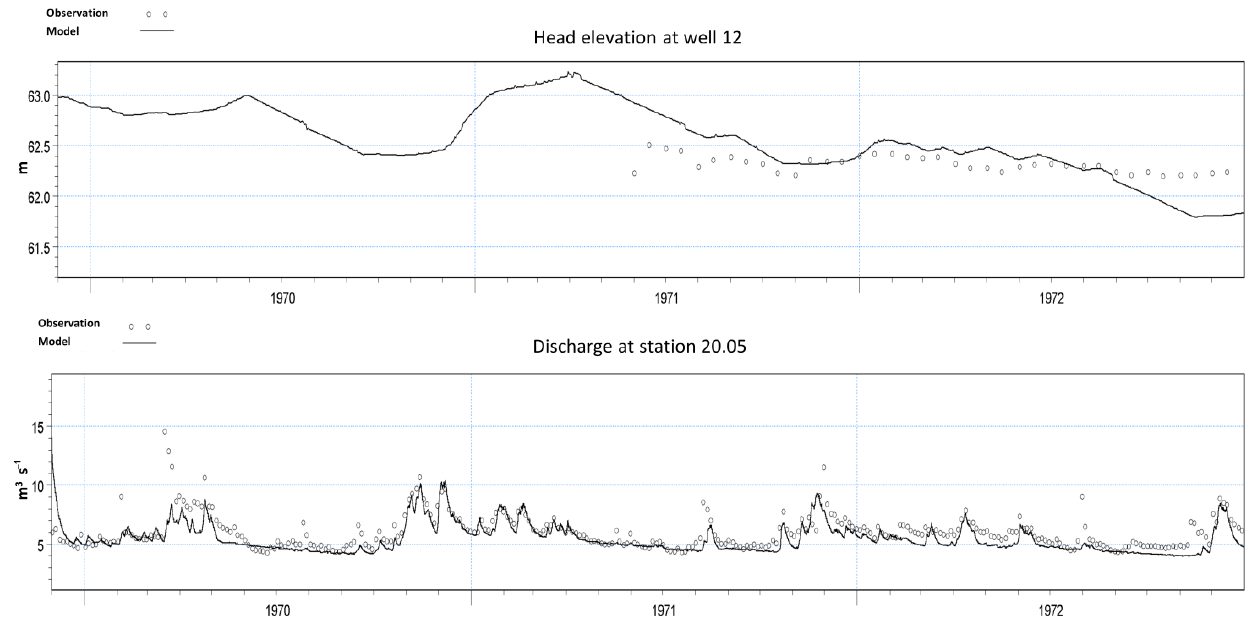
Figure 3. Observed and simulated water table at well 12 (top panel) and hydrograph at station 20.05 (bottom panel) in the Karup